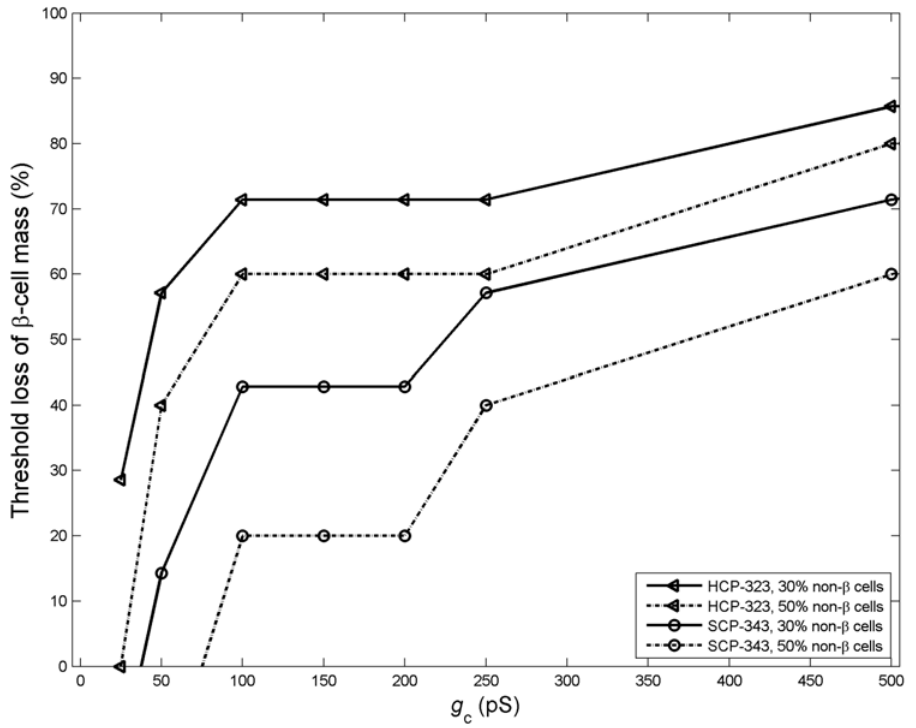
Figure 8. Threshold of b -cell loss that would lead to complete loss of bursting synchronization.